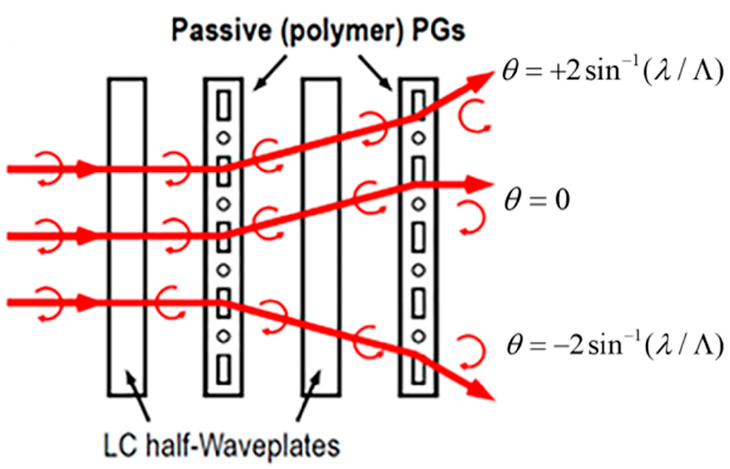
Figure 3. Two liquid crystal half-wave wafers and two LPGGs consist of an LCPG